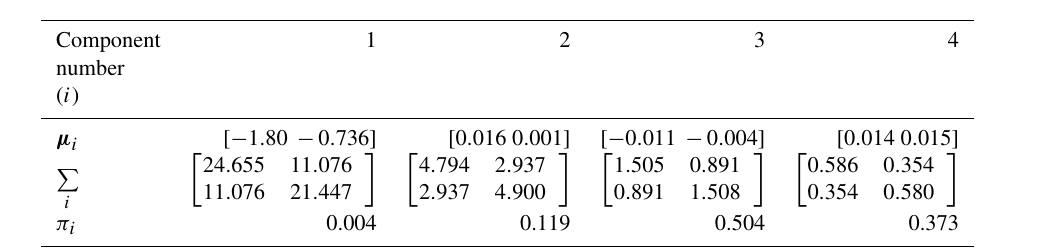
Table 2. Final GMM parameters.